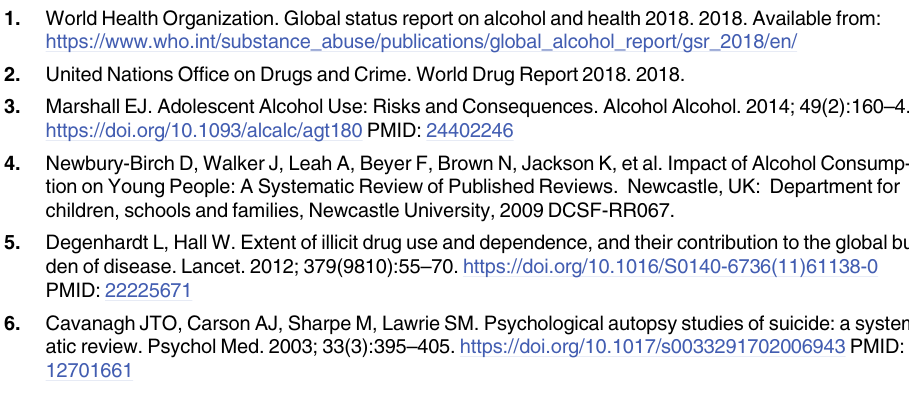
S2 Table. Analyses with cannabis and other drugs examined